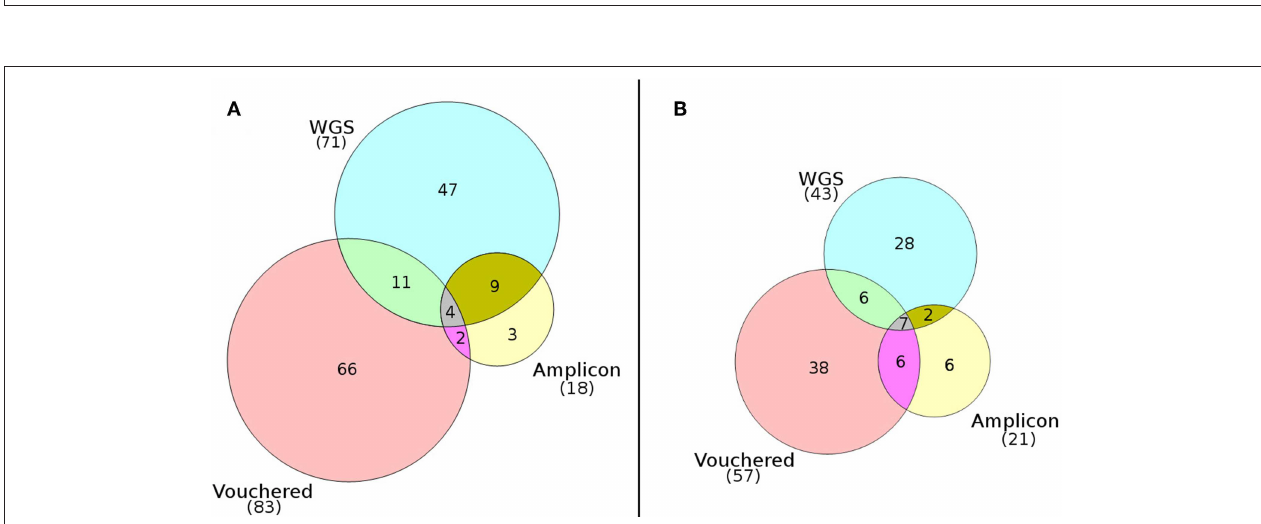
FIGURE 3 | Venn diagrams comparing the numbers of species of lichenized fungi detected at (A) the low-elevation White Oak Branch plot and (B) the high-elevation summit of Clingman’s Dome. Diagrams show an overall low overlap of detected species using the WGS approach (PoD), the amplicon approach (PoD), and the expert-based inventory approach